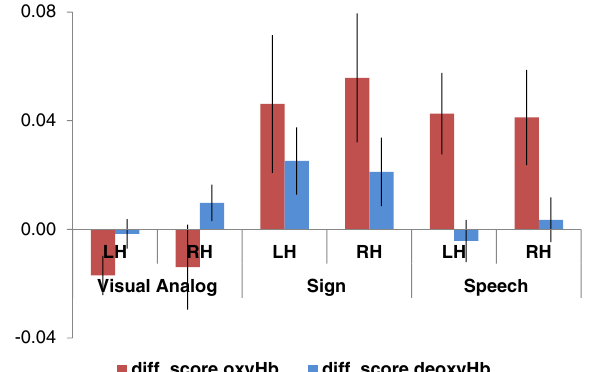
Figure 5. A direct comparison of the effect of reduplication (responses to reduplicative minus responses to non-reduplicative sequences) in the significant clusters in Experiments 1 & 2 in the current study (Exp 1: channels 1, 6, 11 in the LH & 14, 16, 17 in the RH; Exp 2: channels 1, 4, 5, 7 in the LH & 17 in the RH;) and in Exp 1 from Gervain et al. 9 (a permutation test comparing ABB vs. ABC sequences revealed a significant cluster including channels 3, 4, 6 and 9 in the LH and channels 16 and 19 in the RH). Errors bars represent standard errors of the